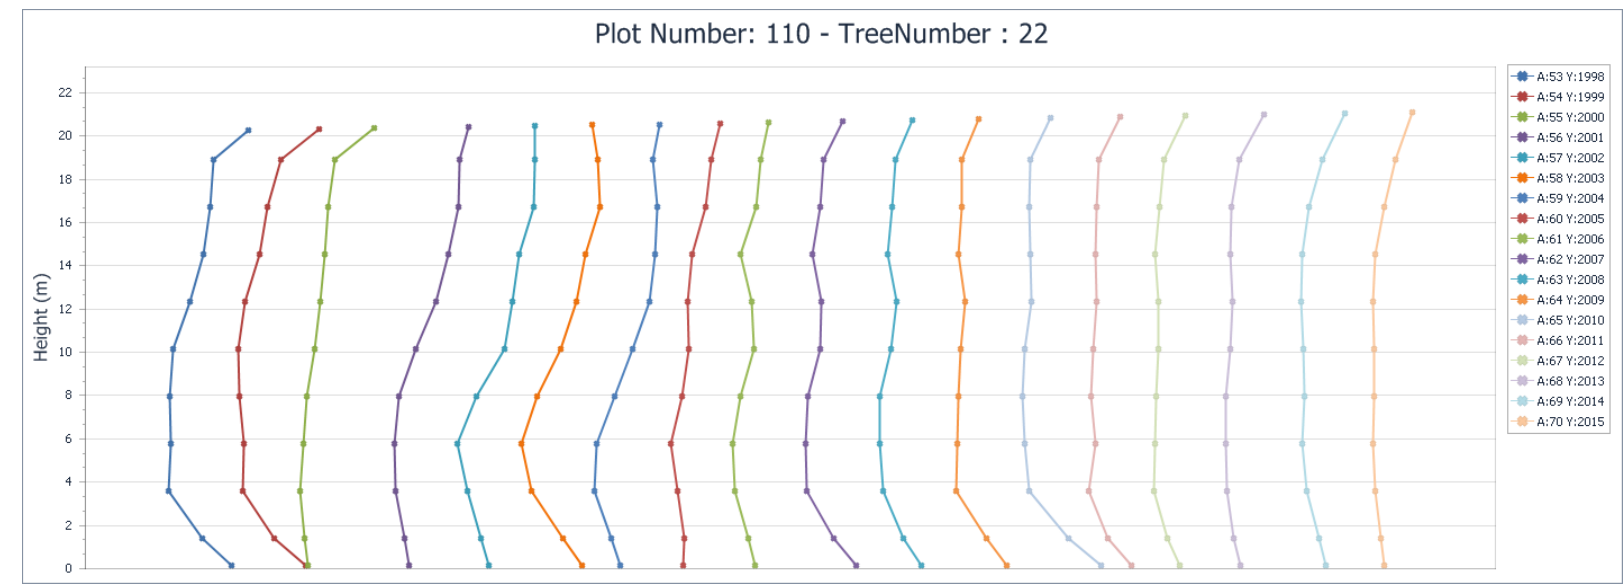
Figure 8. Relational temporal specific volume increment profiles derived from a 70 year-old jack pine tree, illustrating the distribution of relative response throughout the stem for each of the 18 years following the second (last) thinning (1998–2015; see legend).